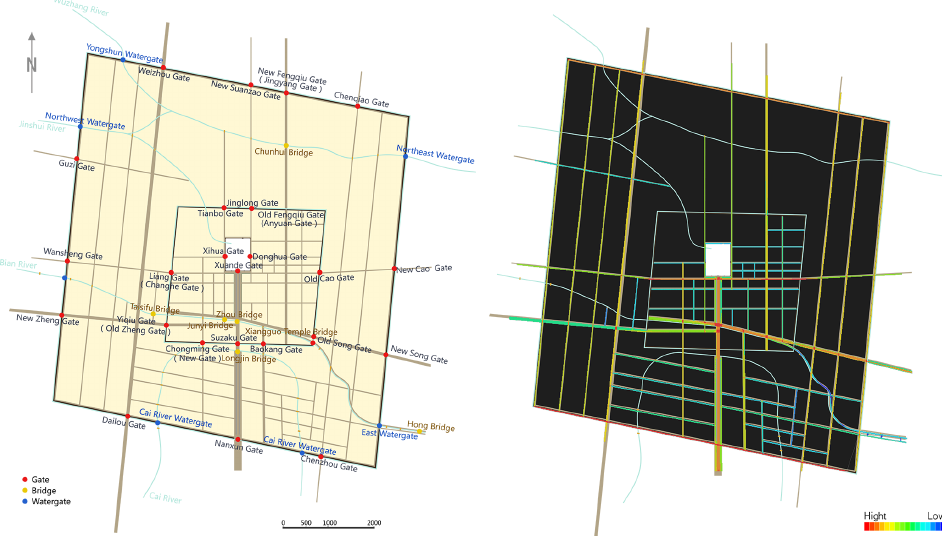
Figure 15. The visual integration value of Dongjing.